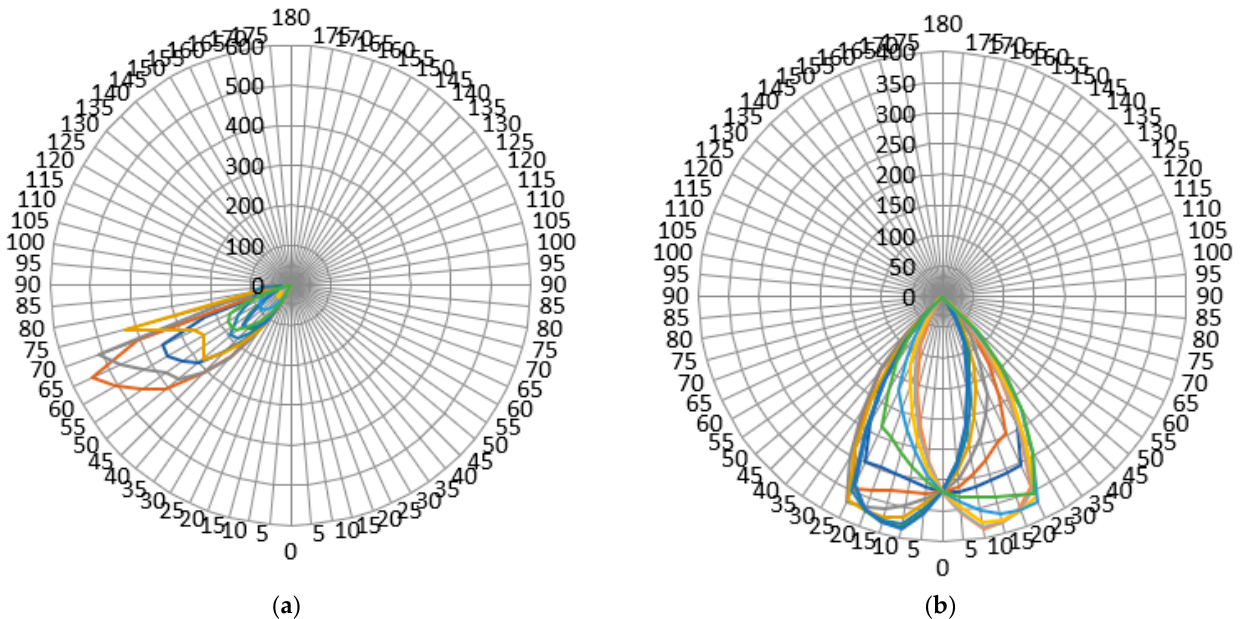
Figure 3. Luminous flux density distribution of the left part of the luminaire ( a ). Luminous flux density distribution of the central part of the luminaire ( b ). Luminous flux density distribution of the right part of the luminaire is symmetrical to ( a ).